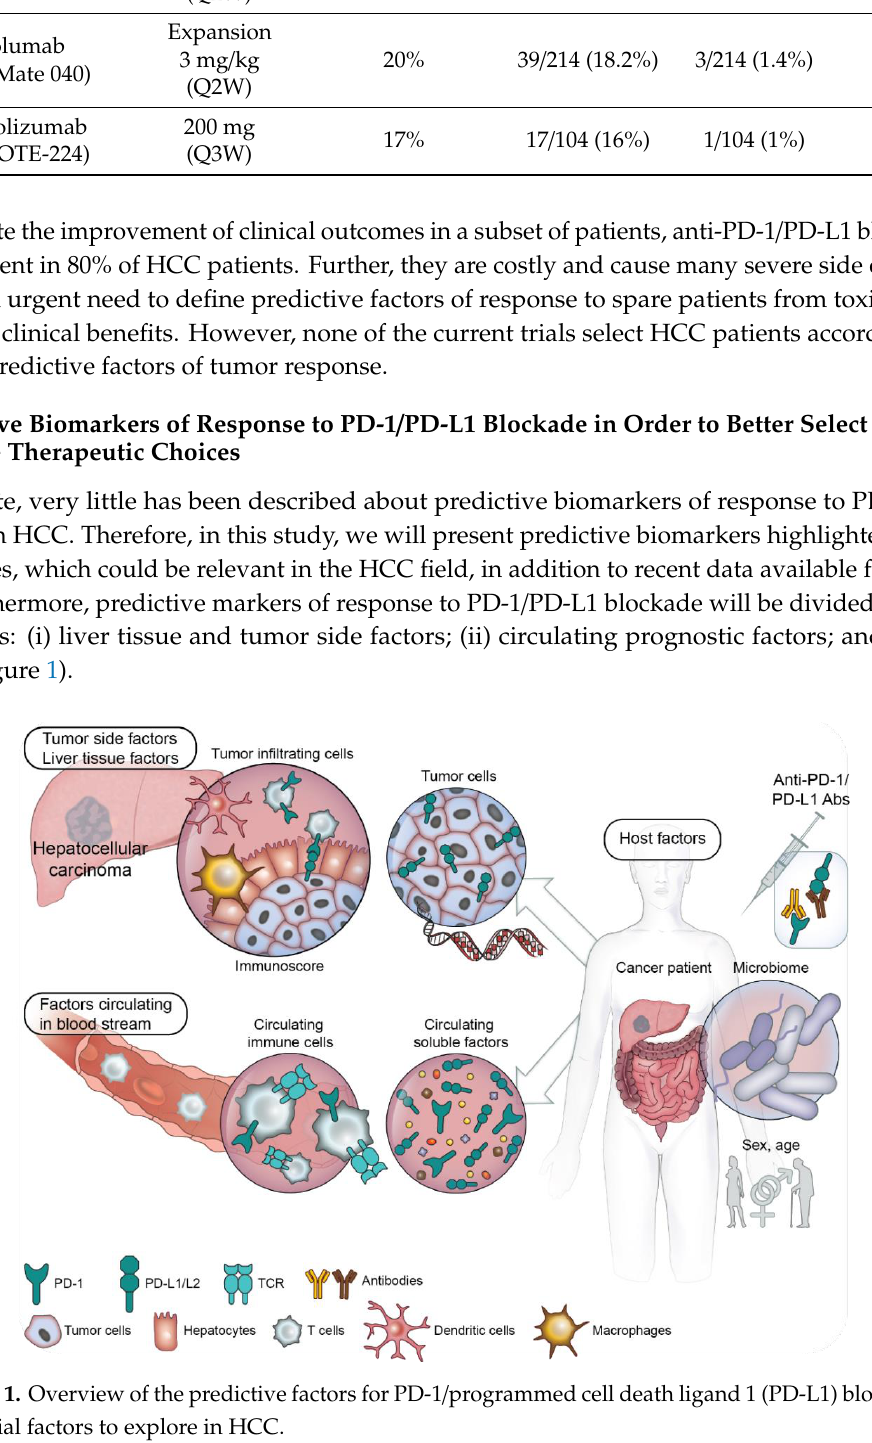
Table 1. Results obtained from clinical trials of programmed cell death protein 1 (PD-1) inhibitors in hepatocellular carcinoma (HCC). Administration every two weeks (Q2W) and every three weeks (Q3W).